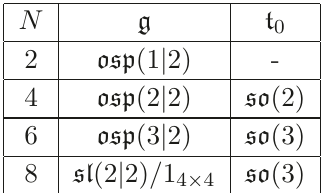
Table 3 . Heterotic AdS 3